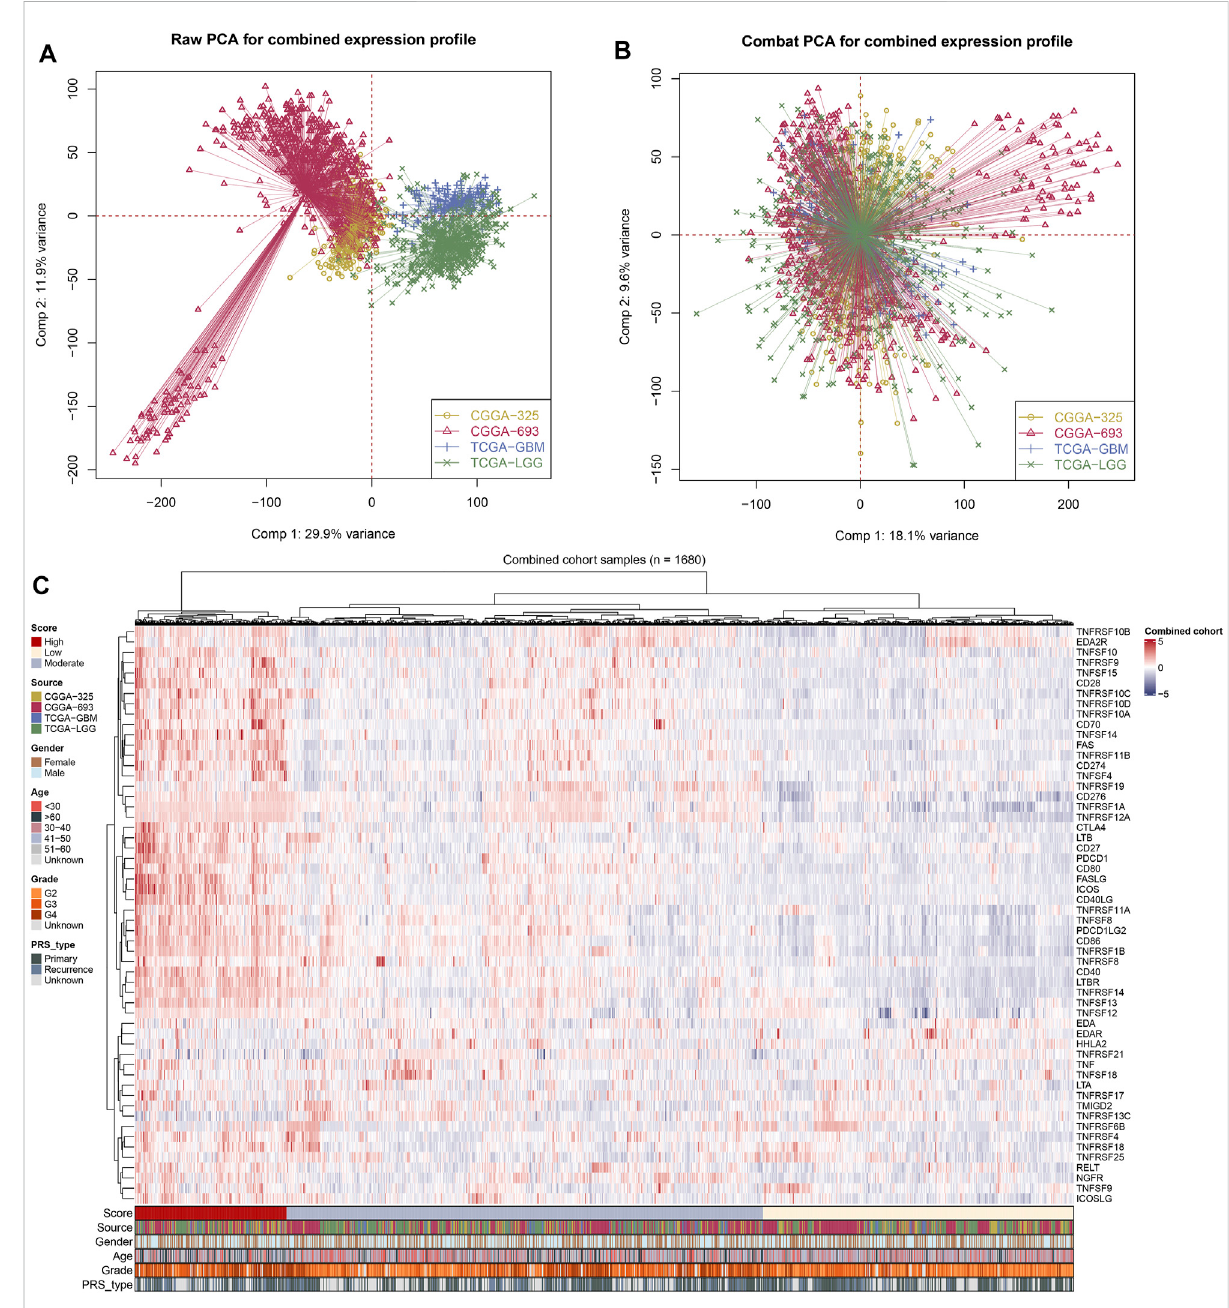
FIGURE 1 Integration of glioma cohorts and theexpressionofcostimulatory molecules. (A) Used inouranalysisof thefour glioma cohorts had signi fi cant batchdifferences(Comp1:29.9%variance,Comp2:11.9%variance). (B) The “ sva ” Rpackageforgliomacohortcombinationssigni fi cantlydecreased the batch difference (Comp 1: 18.1% variance, Comp 2: 9.6% variance). (C) Costimulatory molecules expression pro fi le of all